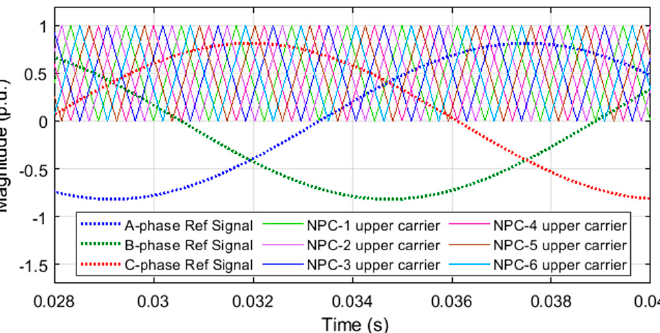
Figure 23. Interleaved SPWM technique for the cascaded three-level NPC converter (upper carriers of six NPC converters are shown only for demonstration).